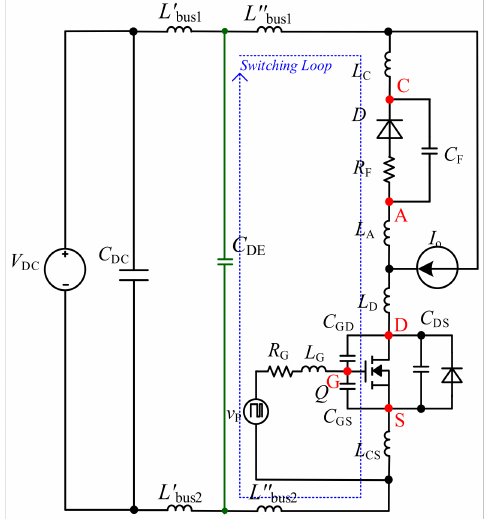
Figure 1. Phase-leg configuration with DC-side Snubber C DE .